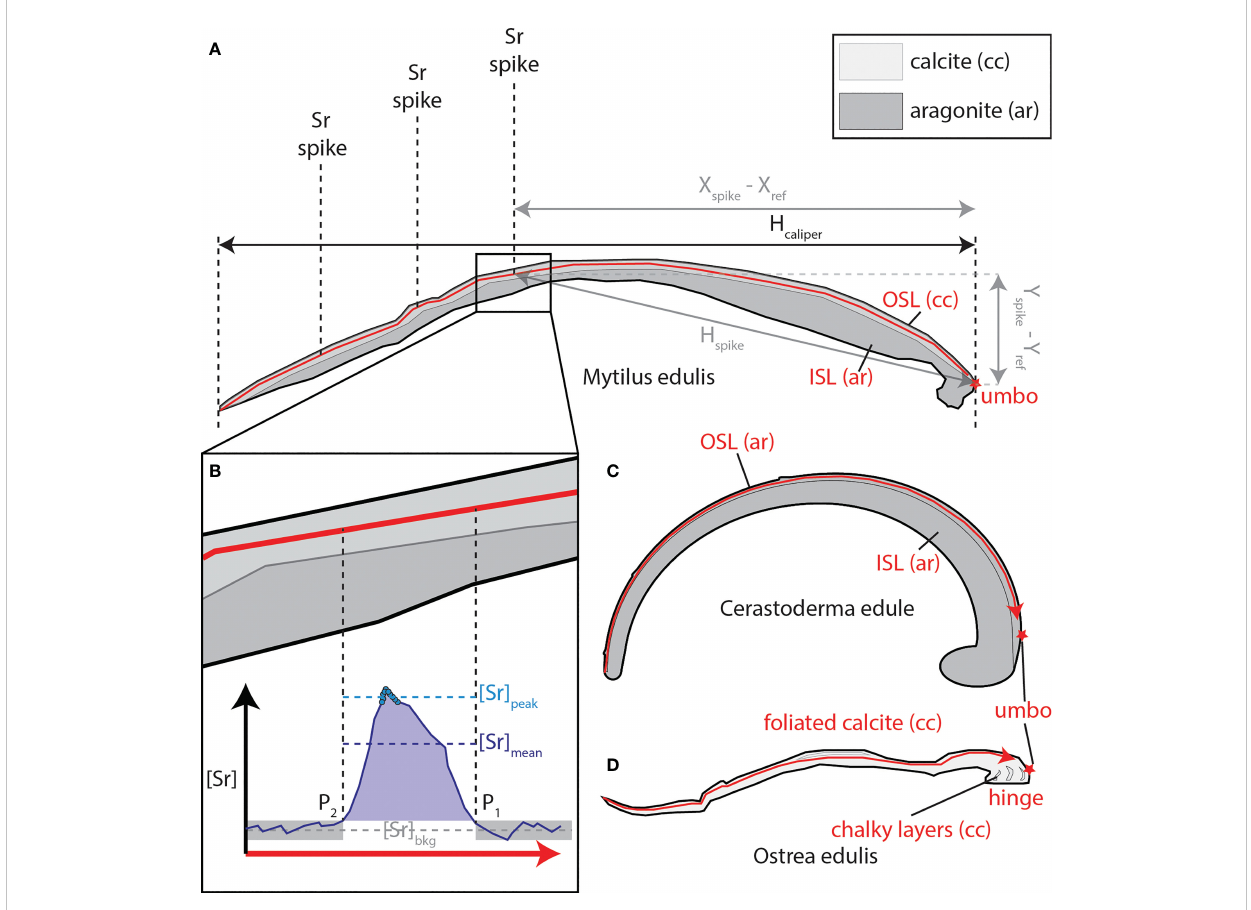
FIGURE 2 (A) Schematic representation of a cross section through a mussel shell and a LAICPMS pro fi le measured through the calcitic outer shell layer (OSL) of this specimen (in red). Dashed lines show the locations of Sr peaks in the shell measured in the transect. Black and grey arrows indicate how shell size could be determined from the location of the Sr peaks ( “ H spike ” , in grey, calculated from X spike – X ref and Y spike - Y ref ) and using calliper measurements of the entire shell ( “ H calliper ” , in black). The red star indicates the reference position at the umbo used to determine shell size based on the position of Sr spikes. (B) Insert showing a typical Sr peak, with vertical dashed lines showing beginning (P 1 ) and end (P 2 ) of the peak in growth direction (note that LAICPMS scan direction is from left to right). [Sr] bkg = Background Sr concentration, [Sr] peak = peak Sr concentration (peak “ height ” ), [Sr] mean = mean Sr concentration in the peak. (C) Schematic cross section through a cockle shell, showing aragonitic outer shell layer (OSL) and inner shell layer (ISL). Red arrowed line shows the path of a typical LAICPMS transect through this species. (D) Schematic cross section through oyster shell showing foliated and chalky calcite layers and the location of the hinge. Red arrowed line shows the path of a typical LAICPMS transect through this species, avoiding the chalky segments. cc, calcite, ar,